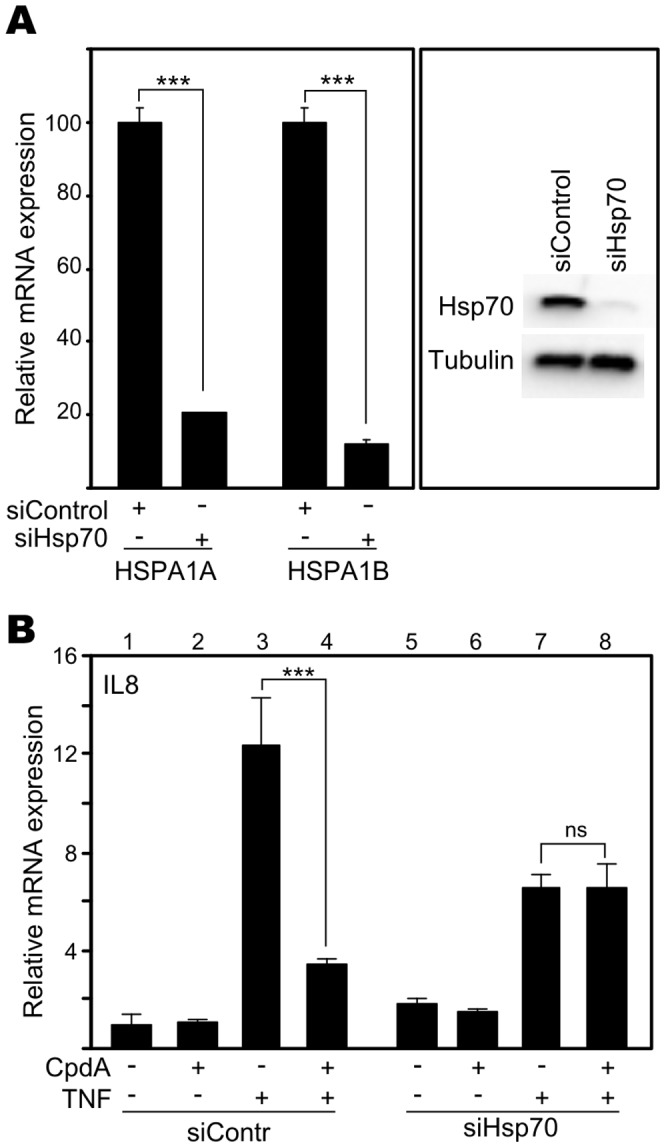
Hsp70 is required to allow the anti-inflammatory activity of Compound A.(A) A549 cells were transfected with siControl or siRNA targeting HSPA1A and HSPA1B (siHsp70). Total RNA or total protein extracts were prepared 48h post transfection. Purified mRNA was subjected to RT-qPCR detecting HSPA1A or HSPA1B gene expression levels and specific results were normalized to housekeeping controls cyclophilin and 28S, as presented in the left panel. For siControl-transfected samples gene expression levels were set at 100%. SiHsp70-transfected results were recalculated accordingly. Statistical analysis (unpaired t-test) was performed to show significant difference between siControl and siHsp70 conditions (*** p<0.001). In the right panel, total cell lysates were subjected to Western blot analysis to detect Hsp70 protein levels. Detection of tubulin served as loading control. (B) In parallel with (A), A549 cells were transfected with siControl or siHsp70. 41h post transfection, cells were pretreated with Solv or CpdA (10µM) for 2h, after which ensued a 6h TNF (2000IU/ml) treatment. Purified mRNA was subjected to RT-qPCR detecting IL8 gene expression levels and specific results were normalized to housekeeping controls cyclophilin and 28S. The condition Solv (siControl) was set as 1 to allow ratio comparisons. Statistical analysis (ANOVA with Tukey’s multiple comparison post test) was performed to show significant difference for selected pair wise comparisons (ns not significant; ** p<0.01; *** p<0.001).